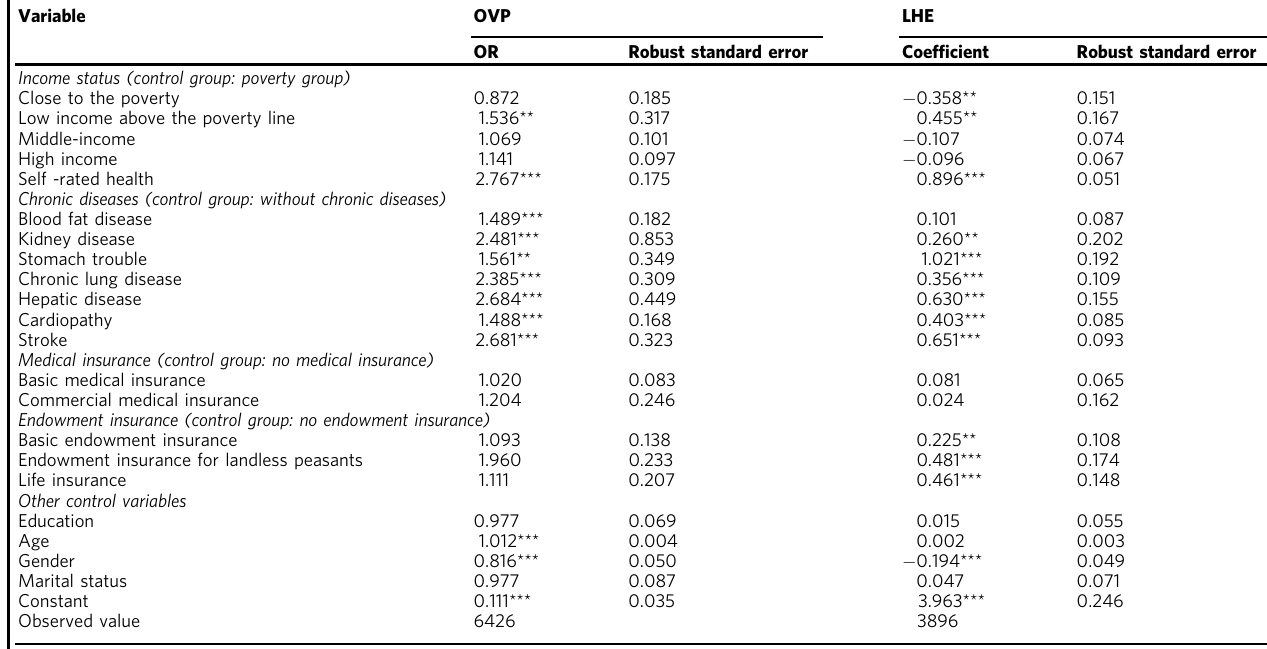
Table 5 Robustness test of the two-part